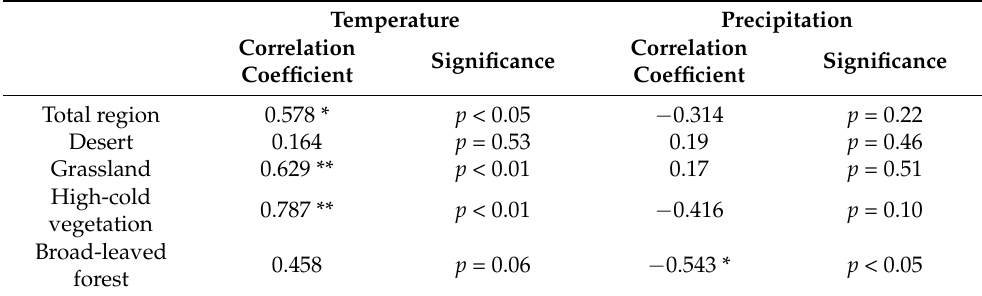
Table 5. Correlation between NPP and climatic factors in each vegetation regionalization of